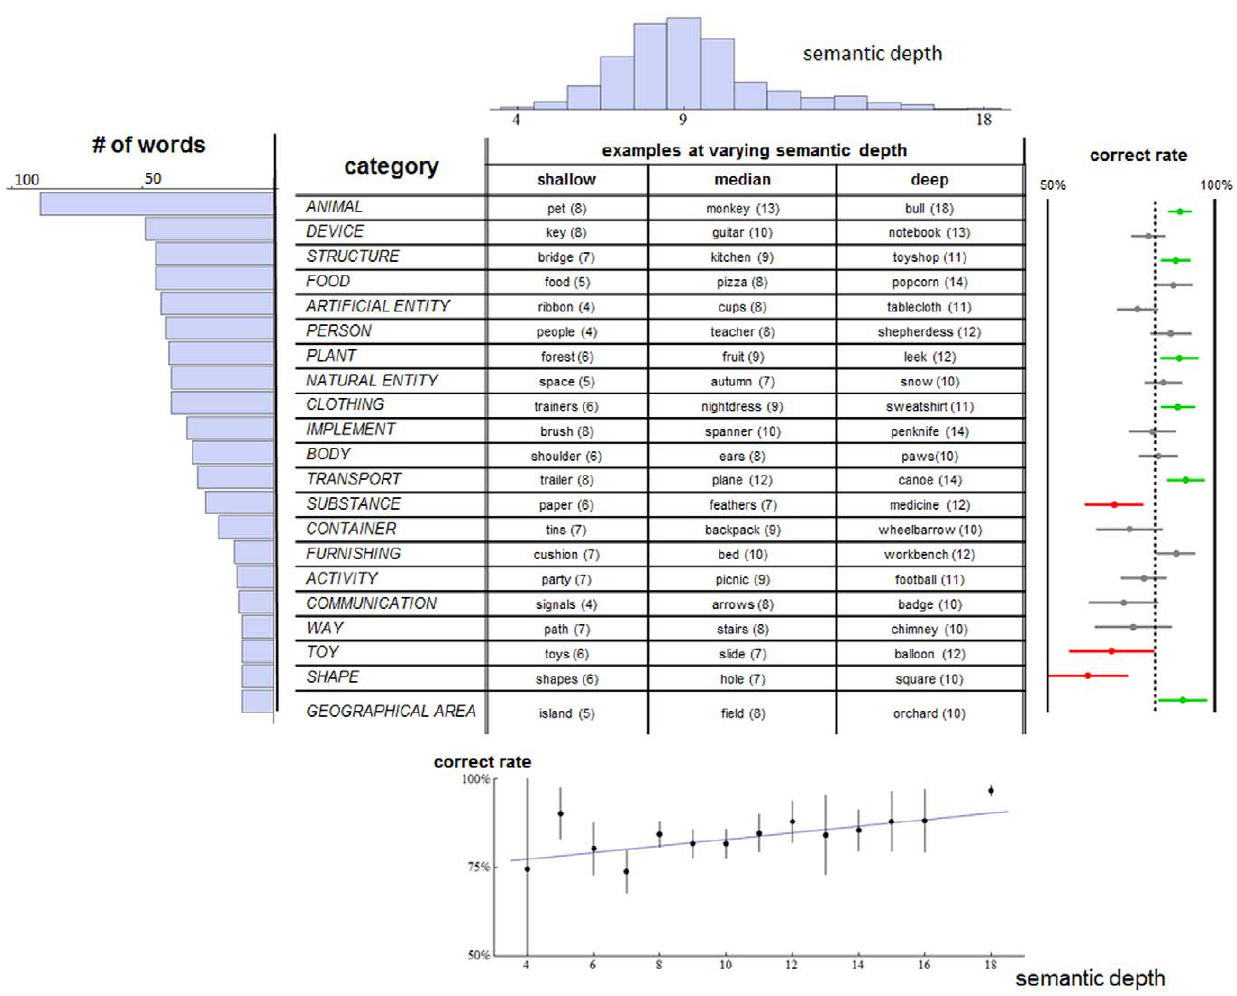
Figure 7. Words used in the experiment with variation of performance by category and semantic depth. The figure is organized by category varying vertically, and semantic depth varying horizontally. The histogram at top shows the distribution of depths for the full set of words in W 660 . The histogram at left, together with the leftmost column of the table, shows the number of words in each category. The other columns give example words (and their depths) for each category. The plots to the right and below show experimental results. At right is shown the word-specific correct rate averaged across the category. The error bars show the 95% confidence intervals of these means. The dashed line is the mean across all words. Categories with means significantly below average have red symbols, significantly above green, others grey. The plot below the table shows mean word-specific performance as a function of semantic depth. Error bars indicate 95% confidence intervals for the means. The best-fit linear function is